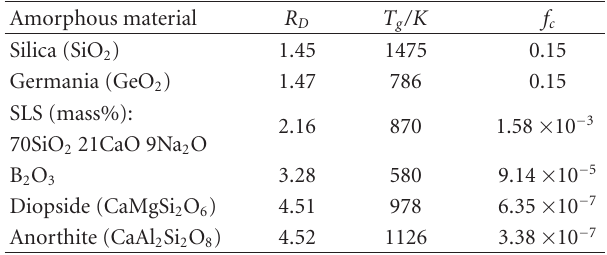
Table 6: Glass transition temperatures of amorphous